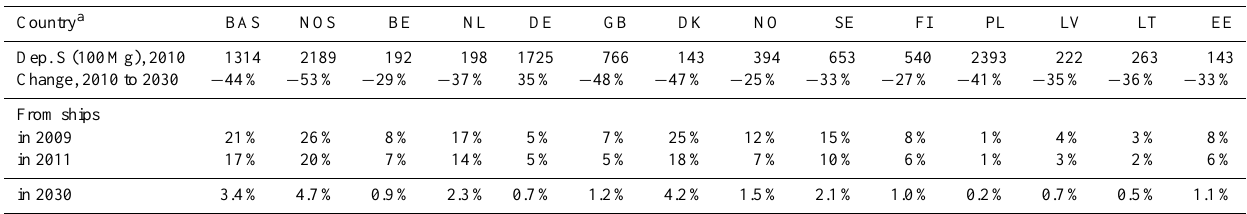
Table 4. Depositions of sulfur with units 100Mg of S calculated with 2010 land-based emissions and ship emissions in the Baltic Sea and the North Sea for 2009. The change in depositions between 2010 (2009 ship emissions) and 2030 is given in percent. The percentage contributions from ships in 2009 and 2011 are calculated with 2010 land-based emissions. Also listed are the percentage contributions from ship emissions in the two sea areas in 2030. Country